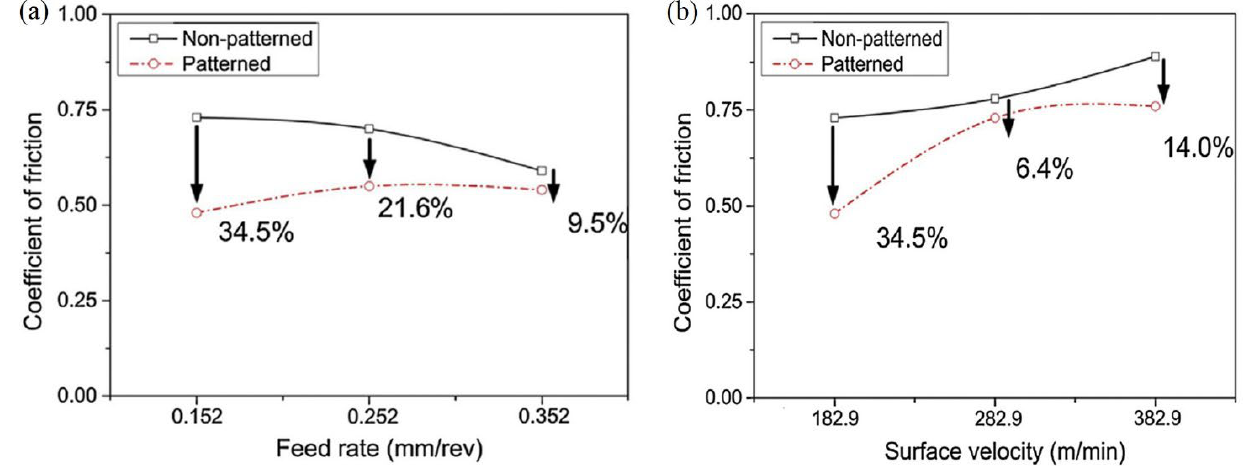
Figure 10. Coefficient of friction of patterned and non-patterned CBN cutting tool according to ( a ) various feed rates; and ( b ) surface velocity [77].